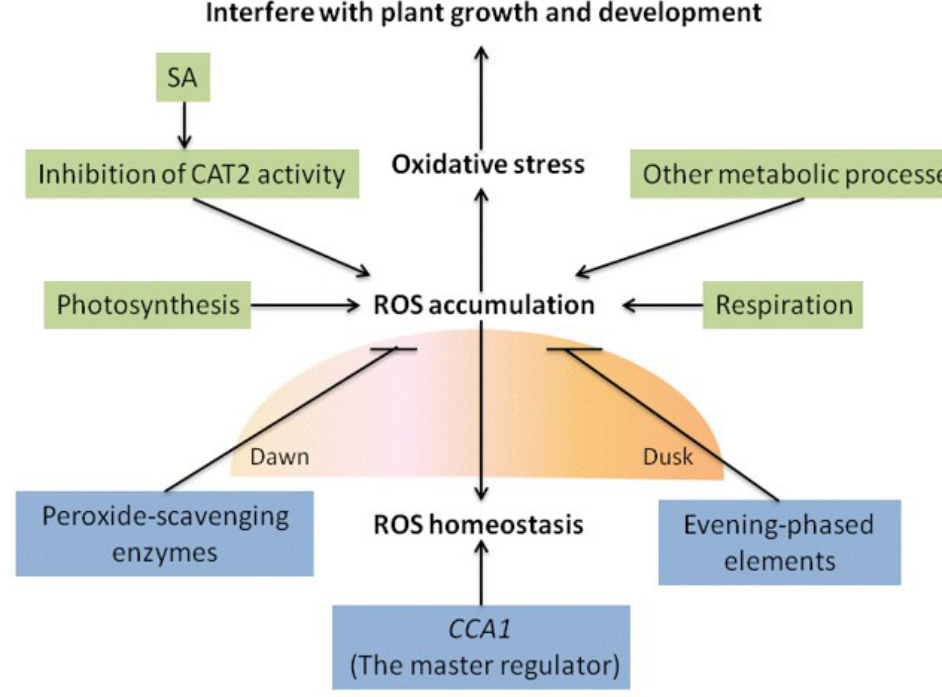
Figure 2. Reactive oxygen species (ROS) homeostasis. ROS, which are generated during photosynthesis, respiration, and other metabolic processes, peak around midday and are toxic to interfere with plant growth and development. CCA1 is a master regulator of ROS homeostasis. In Arabidopsis , inhibition of CAT2 activity by SA leads to increased H 2 O 2 level. Oscillation of peroxide-scavenging enzyme levels is upregulated close to subjective dawn and inhibits ROS production. Evening-phased elements in promoters of antioxidant genes involved in transcriptional regulation were found to mitigate oxidative stress.